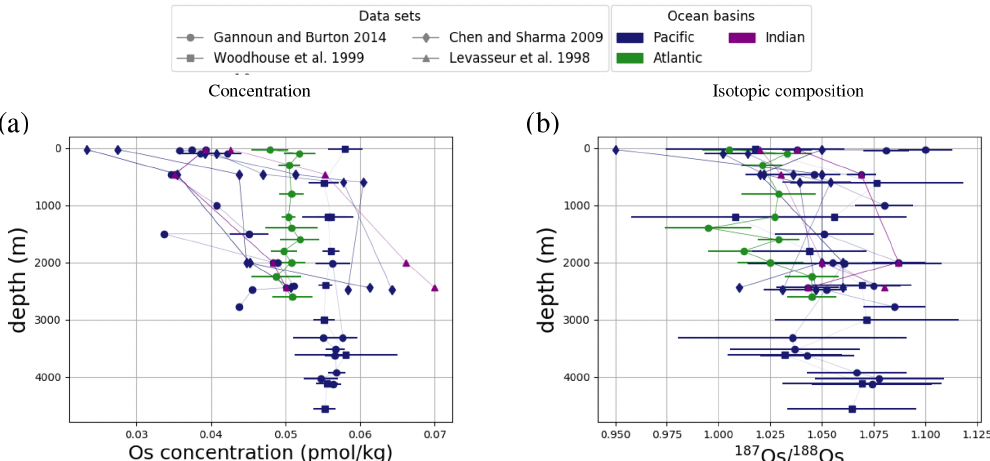
Figure F2. Measured Os ocean profiles. Composites of all available profiles of measured concentrations (a) and isotopic compositions (b) are shown. Data are taken from Levasseur et al. (1998), Woodhouse et al. (1999), and Gannoun and Burton (2014).